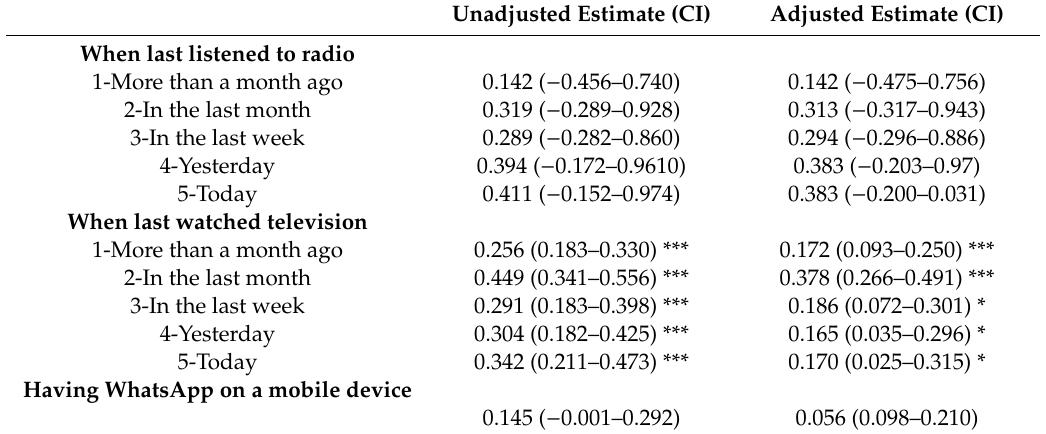
Table 6. Child eating soil knowledge indicators associated with media